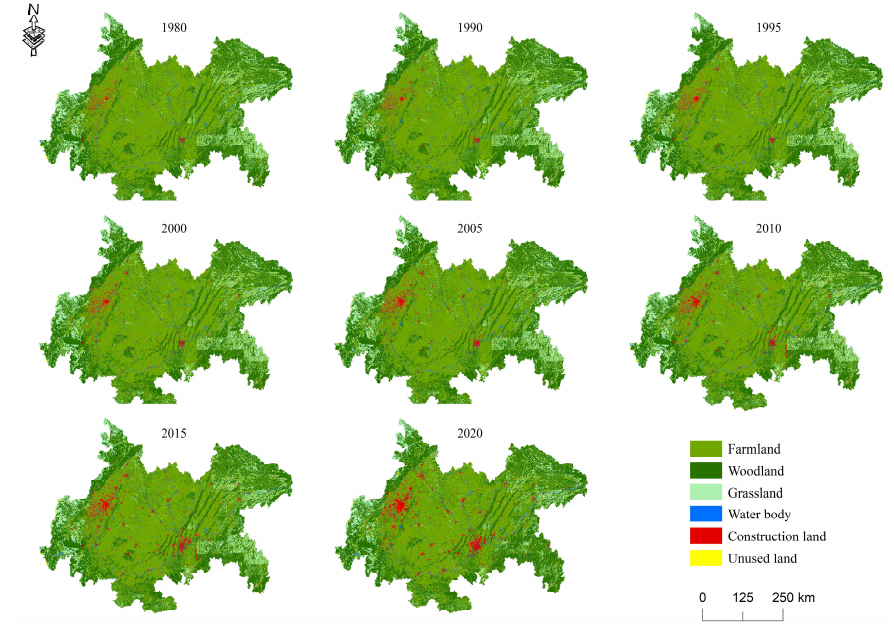
Figure 2. Land use/land cover map of the Chengdu-Chongqing Megalopolis.